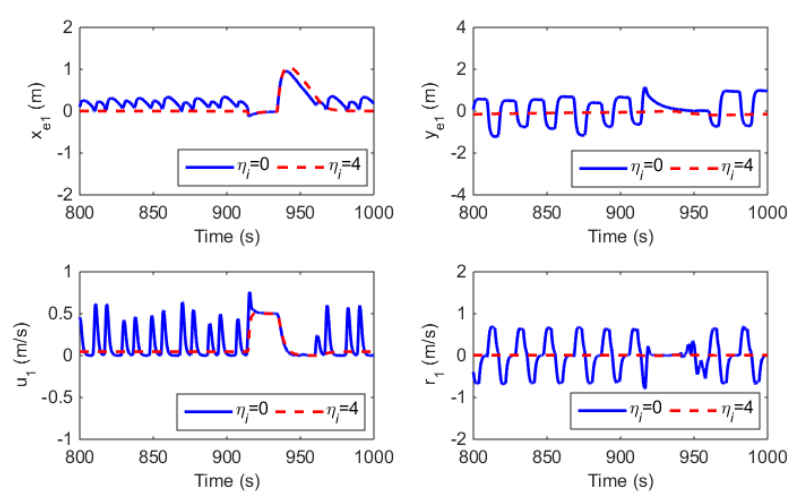
Figure 14. Comparisons on maneuvering errors and velocity signals of individual AUV.